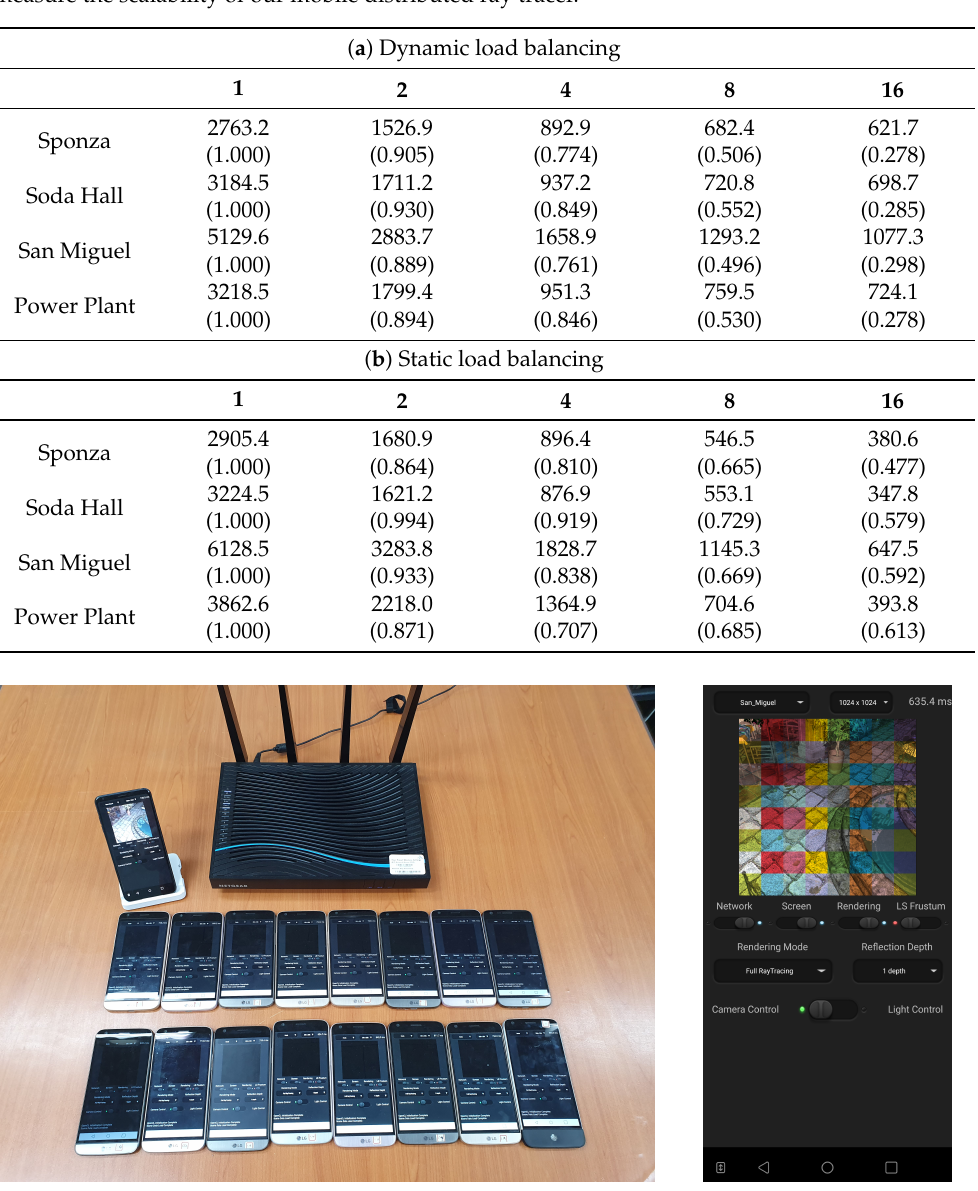
Table 9. Mobile distributed ray tracing times for two load balancing strategies. The times to render an image of 1024 × 1024 pixels using 128 × 128 tiles are reported in milliseconds for different numbers of worker nodes that participate in distributed computing. The efficiency numbers in parentheses measure the scalability of our mobile distributed ray tracer.